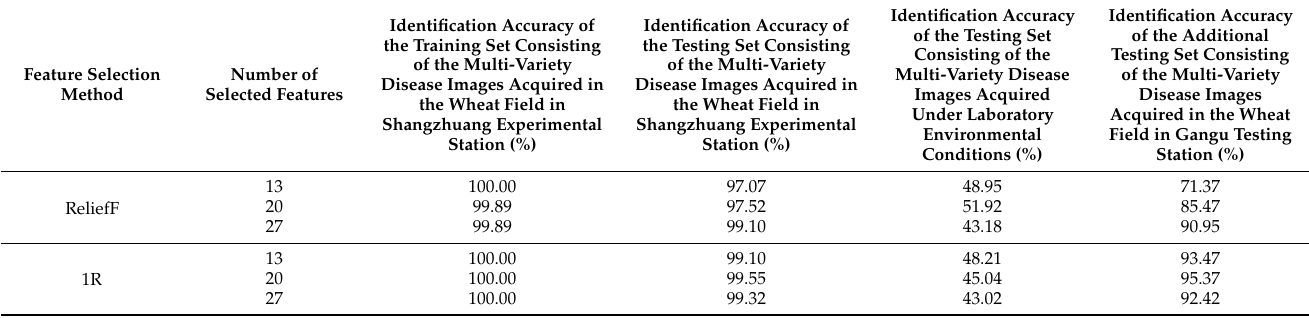
Table 9. Disease identification results of the RF models built with features selected based on the multi-variety disease image dataset consisting of images acquired in the wheat field in Shangzhuang Experimental Station using feature selection methods including ReliefF and 1R,